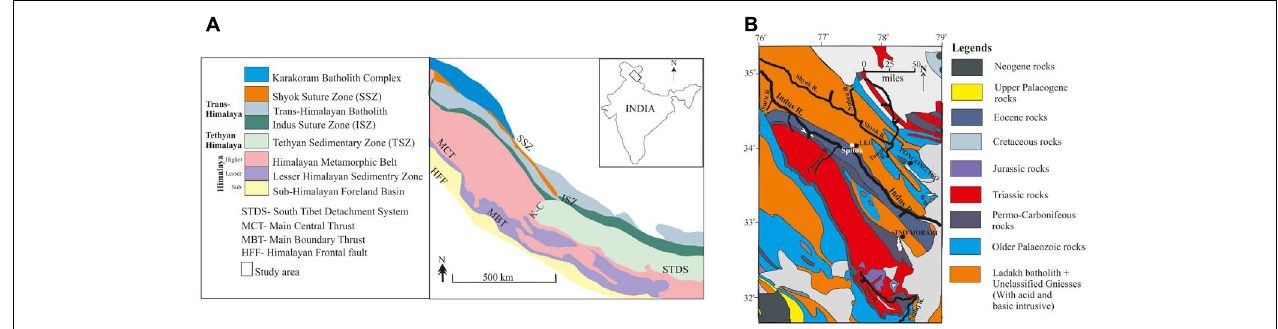
FIGURE 1 | (A) Map showing major mountain ranges and rivers of the NW India, and (B) Geological map of the Ladakh and Spiti valley of NW Himalaya including major rivers (please see text for lithological details). The figure also shows the Spituk site, situated near Leh City (solid white and black color circles, respectively), to highlight the discrepancy in the chronology under different dating